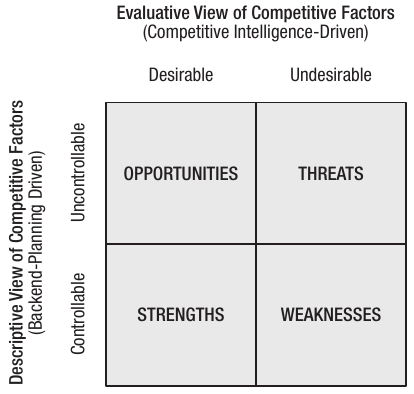
Fig. 10. Dual-perspective SWOT framework: a template for formal